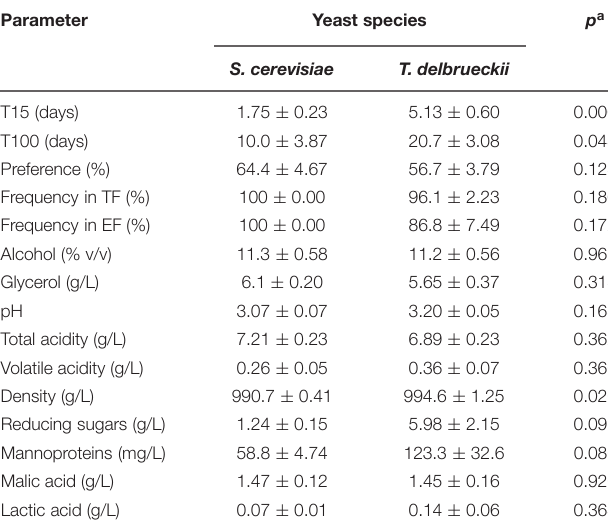
TABLE 2 | Must fermentation parameters and white wine analysis results of independent winery vinifications made with Cigüente and Macabeo musts and of an ANOVA to study the effect of single initial inoculation with S. cerevisiae or T. delbrueckii